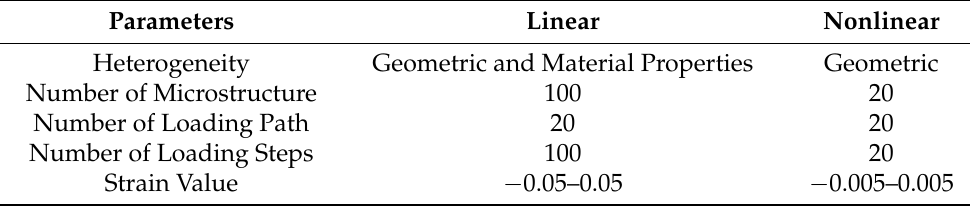
Table 2. Design of experiment for learning response of heterogeneous microstructure.